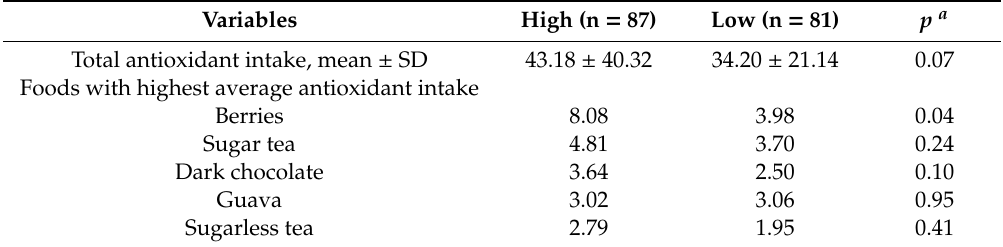
Table 2. The comparison of total antioxidant intake and dietary pattern between high and low exposure